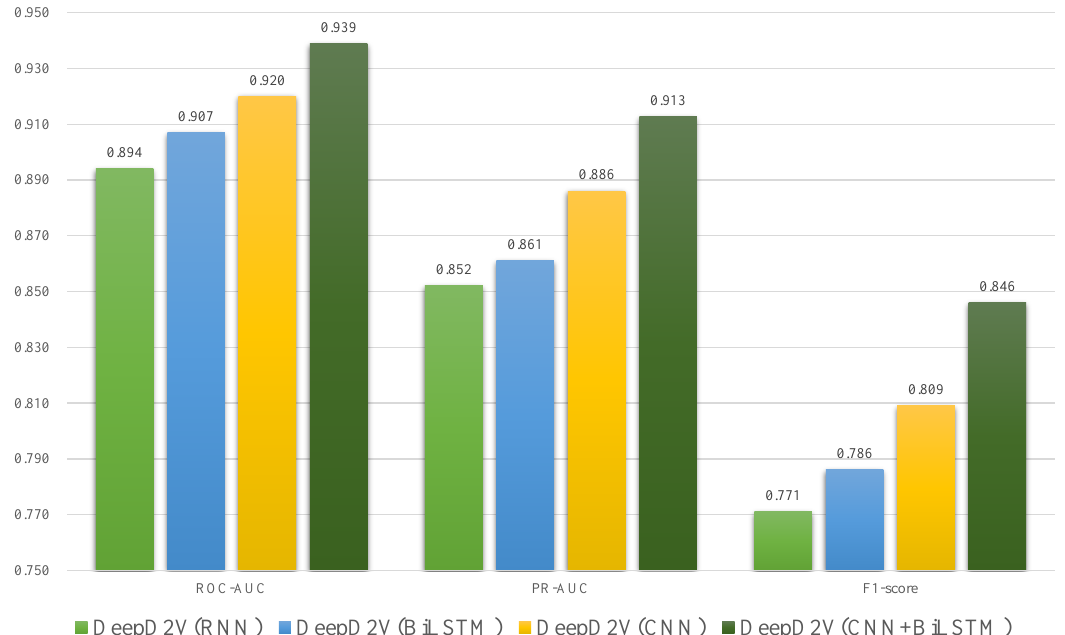
Figure 7. Comparison of DeepD2V with CNN-only, RNN-only, and hybrid structure of CNNs and RNNs on 50 public ChIP-seq datasets under the ROC AUC, PR AUC, and F1-score